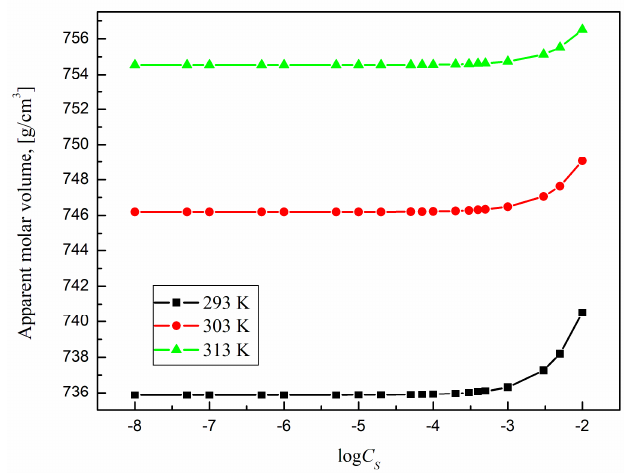
Figure 16. The apparent molar volume ( φ V ) of TS-OE12 vs. the logarithm of its concentration (log C S ) at 293 K, 303 K and 313 K.